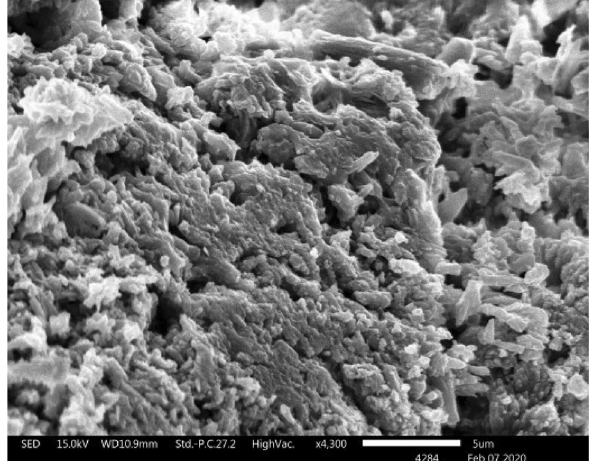
Figure. 5. SEM images of SrZnO